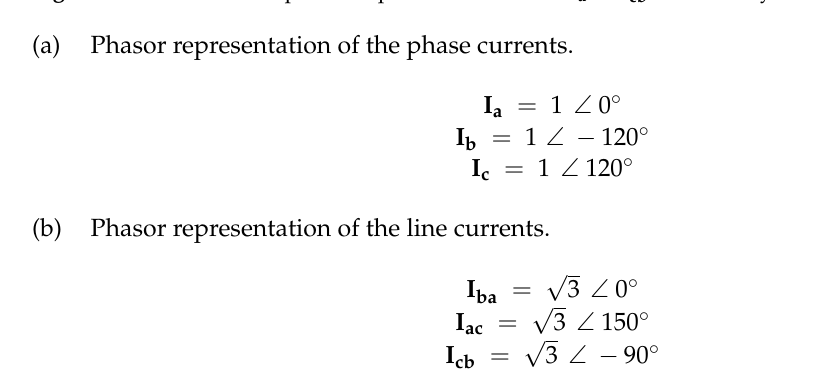
(b) Phasor representation of the line currents.